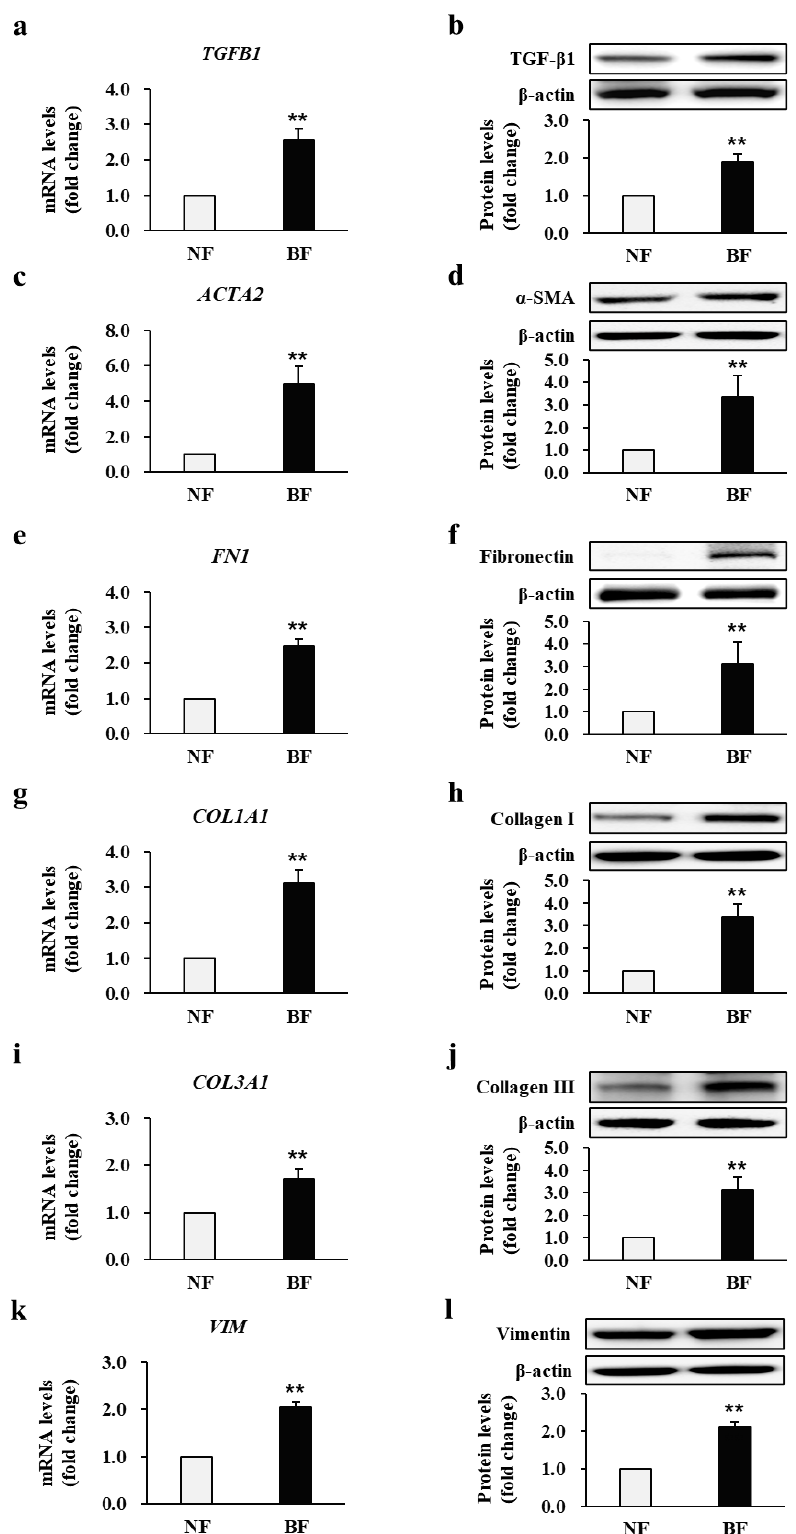
Figure 2. Transcriptional and translational levels of fibrotic markers. The mRNA and protein levels of ( a , b ) TGF- β 1 ( TGB1 ), ( c , d ) α -SMA ( ACTA2 ), ( e , f ) fibronectin ( FN1 ), ( g , h ) collagen I ( COL1A1 ), ( i , j ) collagen III ( COL3A1 ), and ( k , l ) vimentin ( VIM ) in burn-wound fibroblasts (BF) were compared with and normalized to those in normal fibroblast (NF) expression levels for each patient. ** p < 0.01. Data represent mean ± standard error of the mean; n = 34 (NF) and n = 34